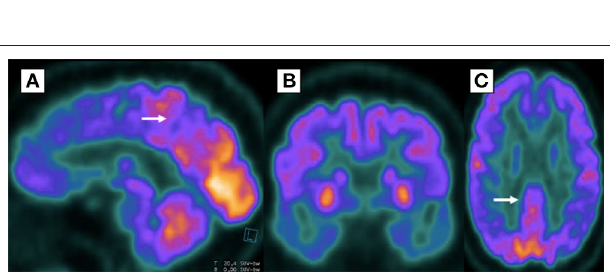
FIGURE 4 | Bilateral frontal hypometabolism (A,B) , more evident in the medial and mid-basal frontal lobe (C) in 18-fluorodeoxyglucose positron emission